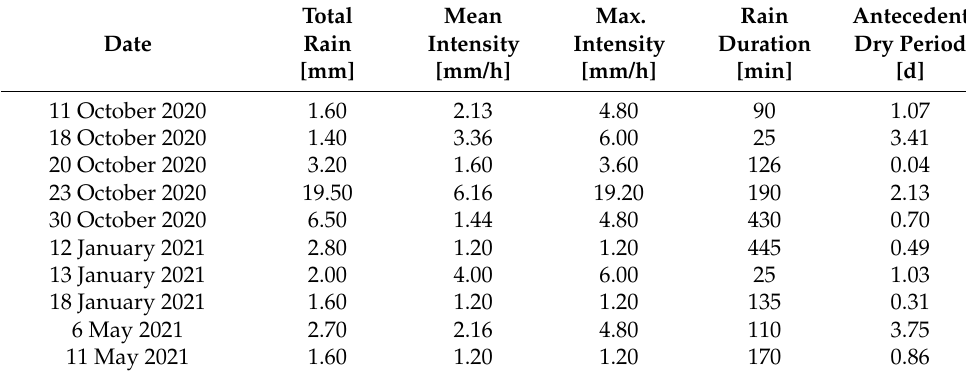
Table 3. Precipitation data of the 10 studied rainfall